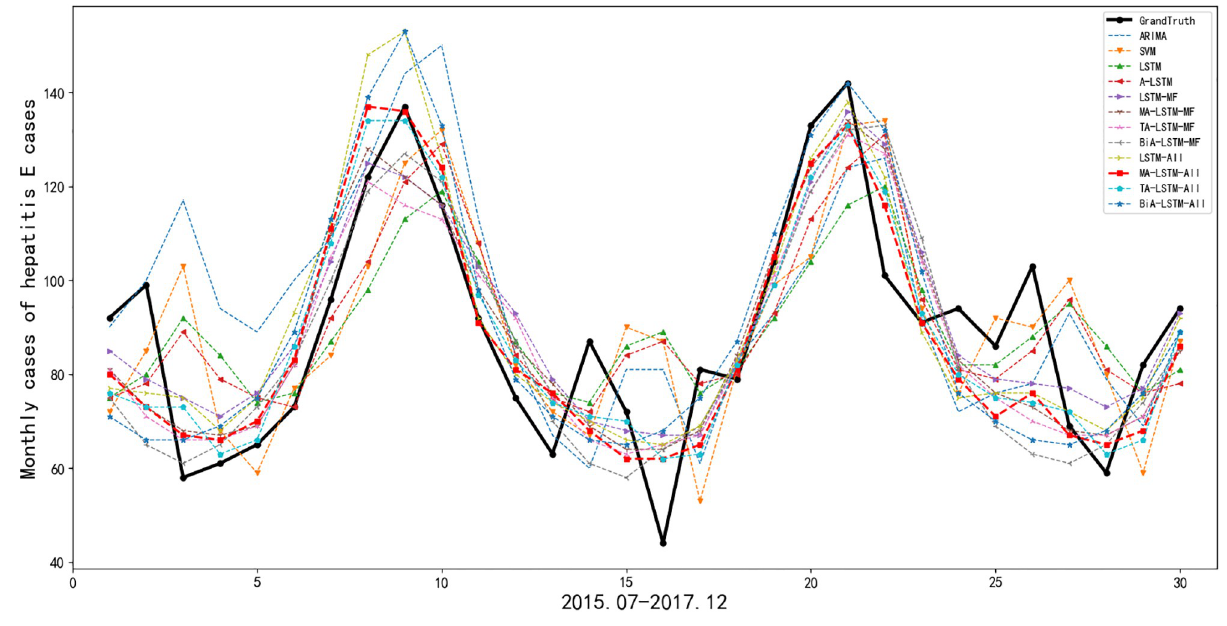
Fig 6. Prediction values of monthly cases of hepatitis